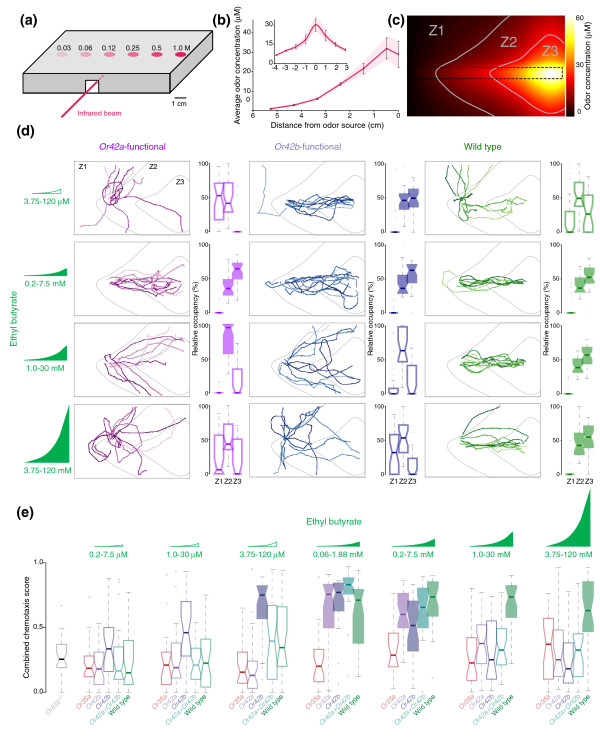
Chemotaxis to ethyl butyrate in wild-type and manipulated larvae. (a) Schematic of the multiple odor source assay. Source concentrations (M) used to generate ethyl butyrate gradients. (b) Average odor concentrations (mean ± SEM) obtained by FT-IR for sections along the length and the width (inset) of the arena shown in (a). Odor concentrations (mean ± SEM) were measured 4–12 minutes after loading. (c) Topographic reconstruction of the multiple odor source gradient shown in (b). The odorant line is indicated by the dashed box. The arena was subdivided into three concentration zones indicated by the gray lines (Z1 = low (0–8.7 μM), Z2 = medium (8.7–24.2 μM), and Z3 = high (24.2–60 μM)). (d) Odor-evoked behavior of Or42a-functional (left), Or42b-functional (middle) and wild-type (right) larvae tested in the multiple source assay. Source concentration range is indicated at the left. Gradient cartoons are not to scale and represent the relative concentration differences between the gradients. Low-concentration gradients are indicated with open gradient symbols and high concentration gradients with filled gradient symbols. Ten merged tracks, acquired consecutively, are shown per genotype and stimulus. Percentages of time in zones Z1–Z3 are represented at the right of the tracks as boxplots (n = 30), in which the boundaries represent first and third quartiles, the 'waist' indicates the median, whiskers are 1.5 interquartile distance, and outliers are marked with gray dots. Data that differ significantly from Or83b-/- (source range: 3.75–120 mM) are shaded (Wilcoxon test; corrected p < 0.0056). (e) Quantification of the overall alignment of trajectories with the gradient (n = 30 for all genotypes, except for Or35a-functional n = 20–30). Data that differ significantly from Or83b-/- (source range: 3.75–120 mM; gray boxplot at left) are shaded (Wilcoxon test; corrected p < 1.4 × 10-4).